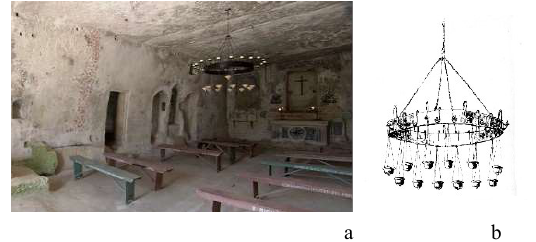
Figure 11: “Cristo alla Selva” Church, Matera (a). Metal chandelier to hang from the ceiling composed of chains and a series of 12 small cups used as oil containers (b).